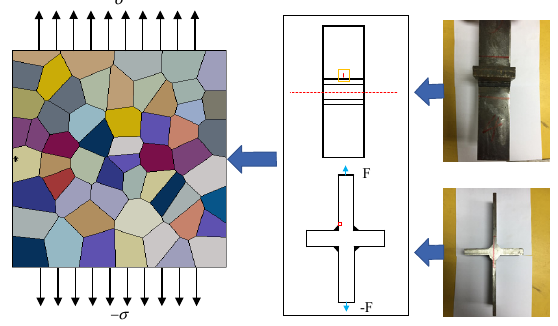
Figure 5. Schematic diagram of model loading.